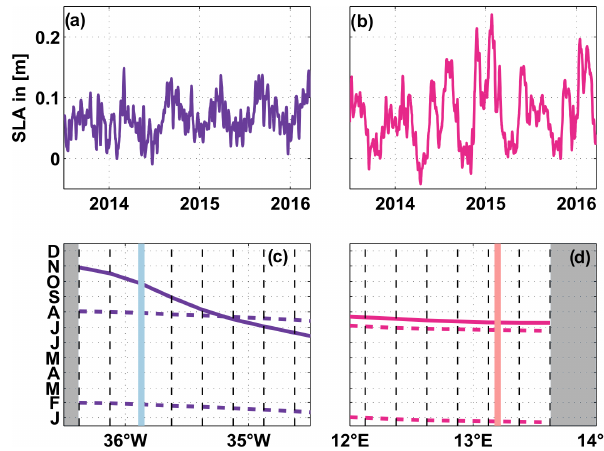
Figure 2. Time series of SLA over the period 2013–2018 – chosen close to the western (purple; a ) and eastern boundaries (magenta; b ). Phases of the minima of the annual (solid curve) and semi-annual (dashed curves) harmonics as a function of longitude near the west- ern (c) and eastern (d) boundaries. In panels (c–d) , the dashed black lines represent the zonal grid spacing of the SLA data and grey ar- eas mark land. Light blue (c) and pink (d) lines mark the locations of the 300m BPRs at the western (c) and eastern (d)